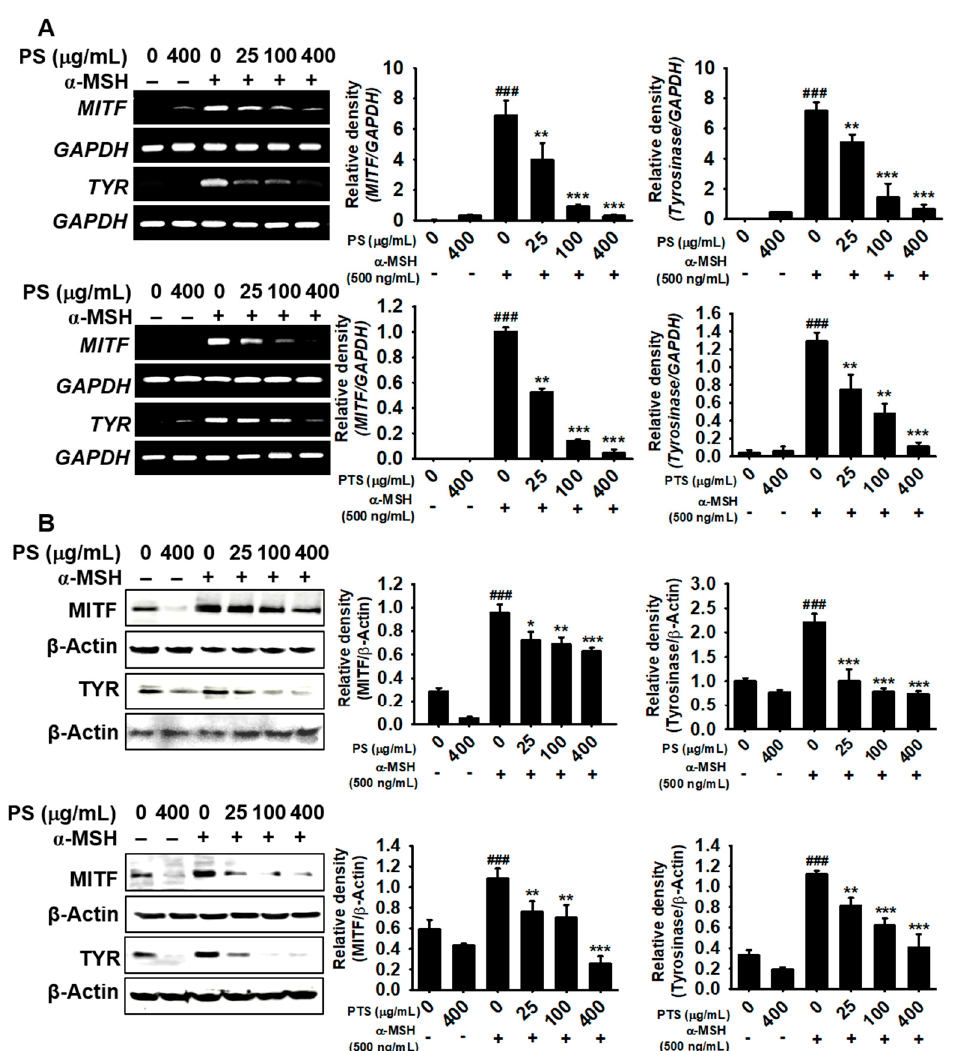
Figure 4. PS and PTS inhibit the expression of MITF and tyrosinase in α‐ MSH ‐ stimulated B16F10 cells. ( A ) B16F10 cells were exposed to 500 ng/mL of α‐ MSH in the presence of PS or PTS (0–400 μ g/mL) for 48 h, and the gene expression of MITF and tyrosinase ( TYR ) was measured. ( B ) Under the same experimental condition, the protein expression of MITF and TYR was measured by western blotting analysis at 72 h. The data are relative to the values in the untreated control group and represented as the means ± SEM of three separate experiments ( n = 3). ### p < 0.001 vs. untreated group; * p < 0.05, ** p < 0.01 and *** p < 0.001 vs. α‐ MSH ‐ stimulated group.